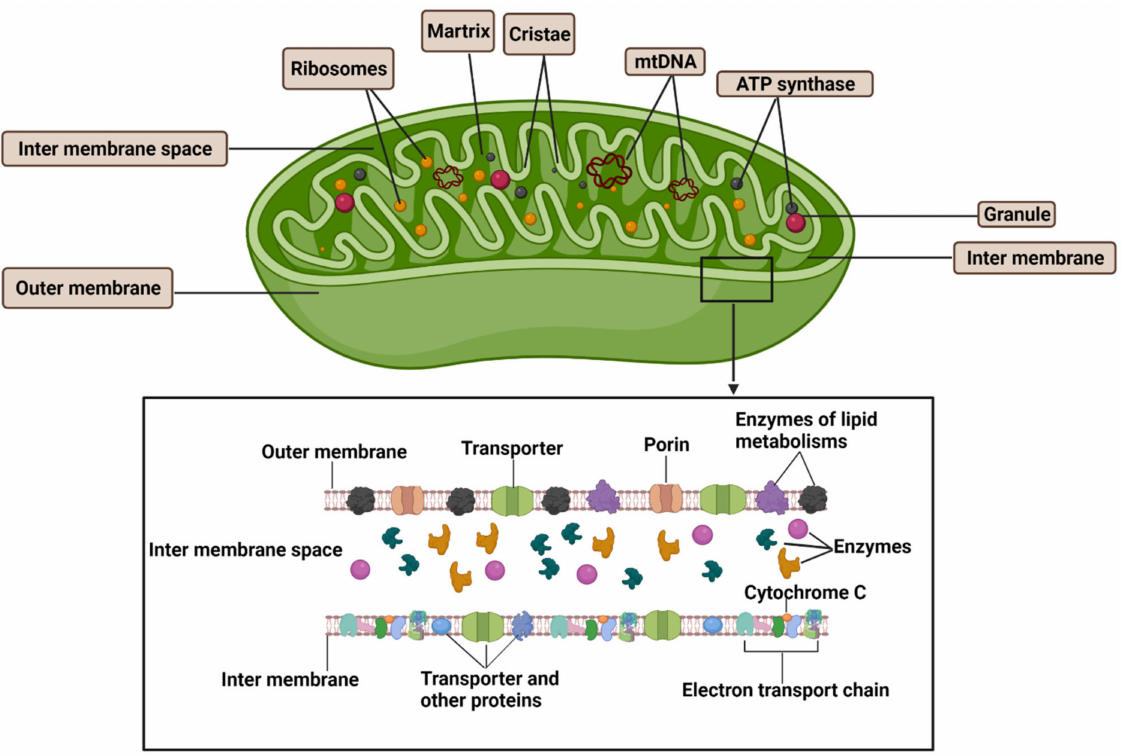
Figure 1. Structure of mitochondria. Mitochondria have an inner and outer membrane with an intermembrane space between them. The outer membrane contains transporters, enzymes for lipid metabolism and proteins (known as porins) that regulate the movement of ions into and out of the mitochondrion. The space within the inner membrane of the mitochondrion is known as the matrix, which contains the DNA, ribosomes, and calcium granules. The inner membrane also contains transporters, a variety of enzymes that regulate the movement of metabolites into and out of the matrix, electron transport chain for energy production via oxidative phosphorylation, and ATP synthase, which generates ATP in the matrix. mtDNA: mitochondria